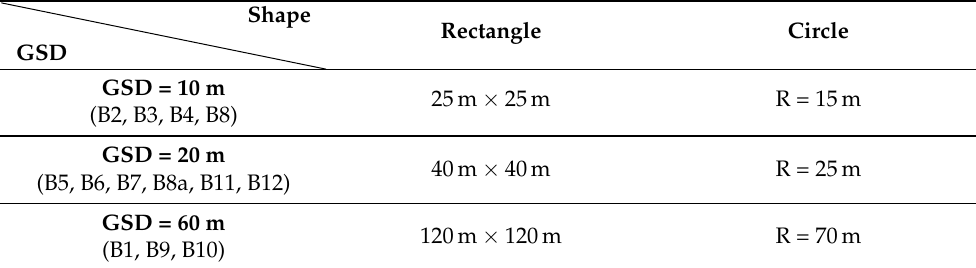
Table 2. Table of the minimum sizes recommended to ensure S2 data reliability, i.e., to avoid aliasing. Shape Rectangle Circle GSD GSD = 10 m 25m × 25m R = 15m (B2, B3, B4, B8) GSD = 20